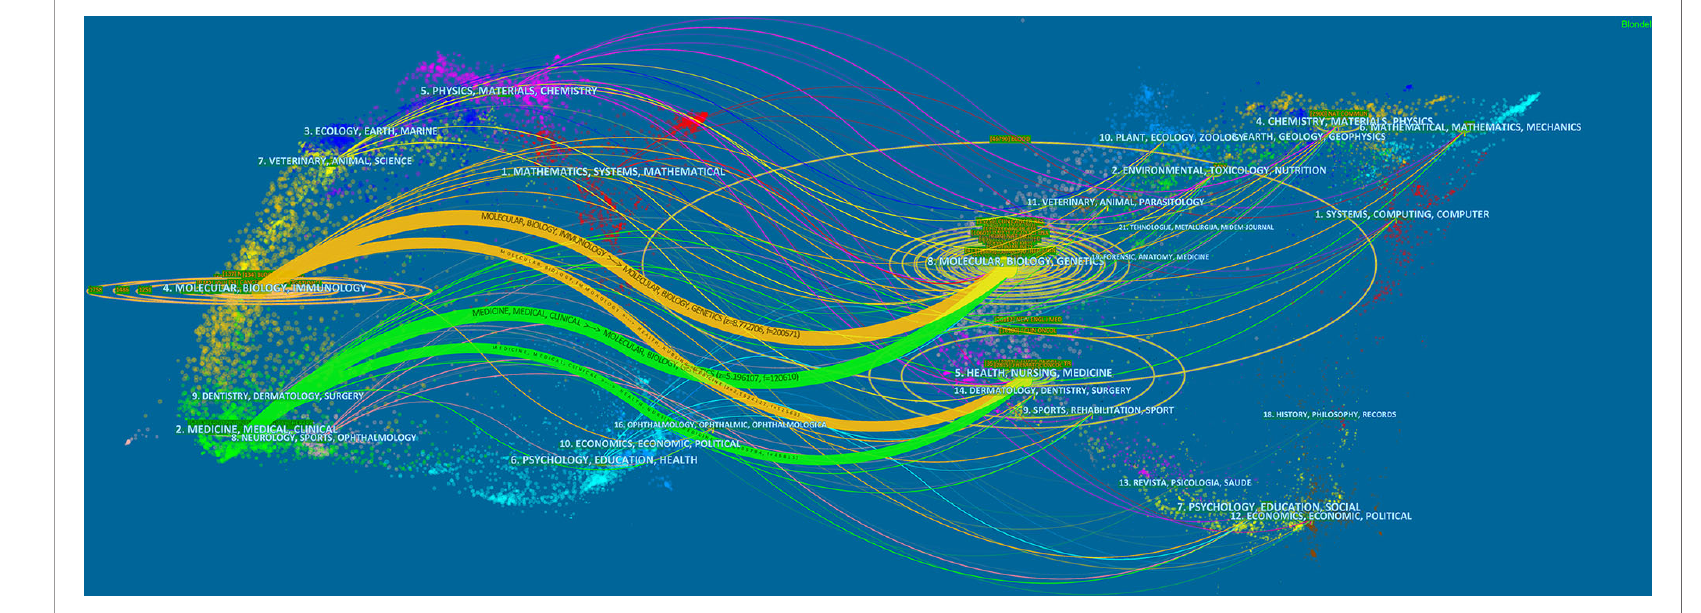
FIGURE 4 | The dual-map overlay of journals on CAR-T cells. Image parameter: a: 2; Source Circle Size: 25; Target Circle Size: 3; Snap to centroids (< Radius): 0. The citing journals are located on the left, and the cited journals are located on the right. The color paths (two orange and two green reference paths) represent the cited